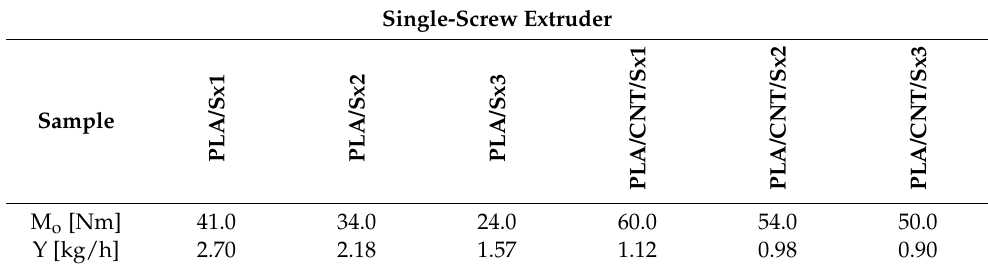
Table 2. Parameters recorded during extrusion—single-screw extruder.